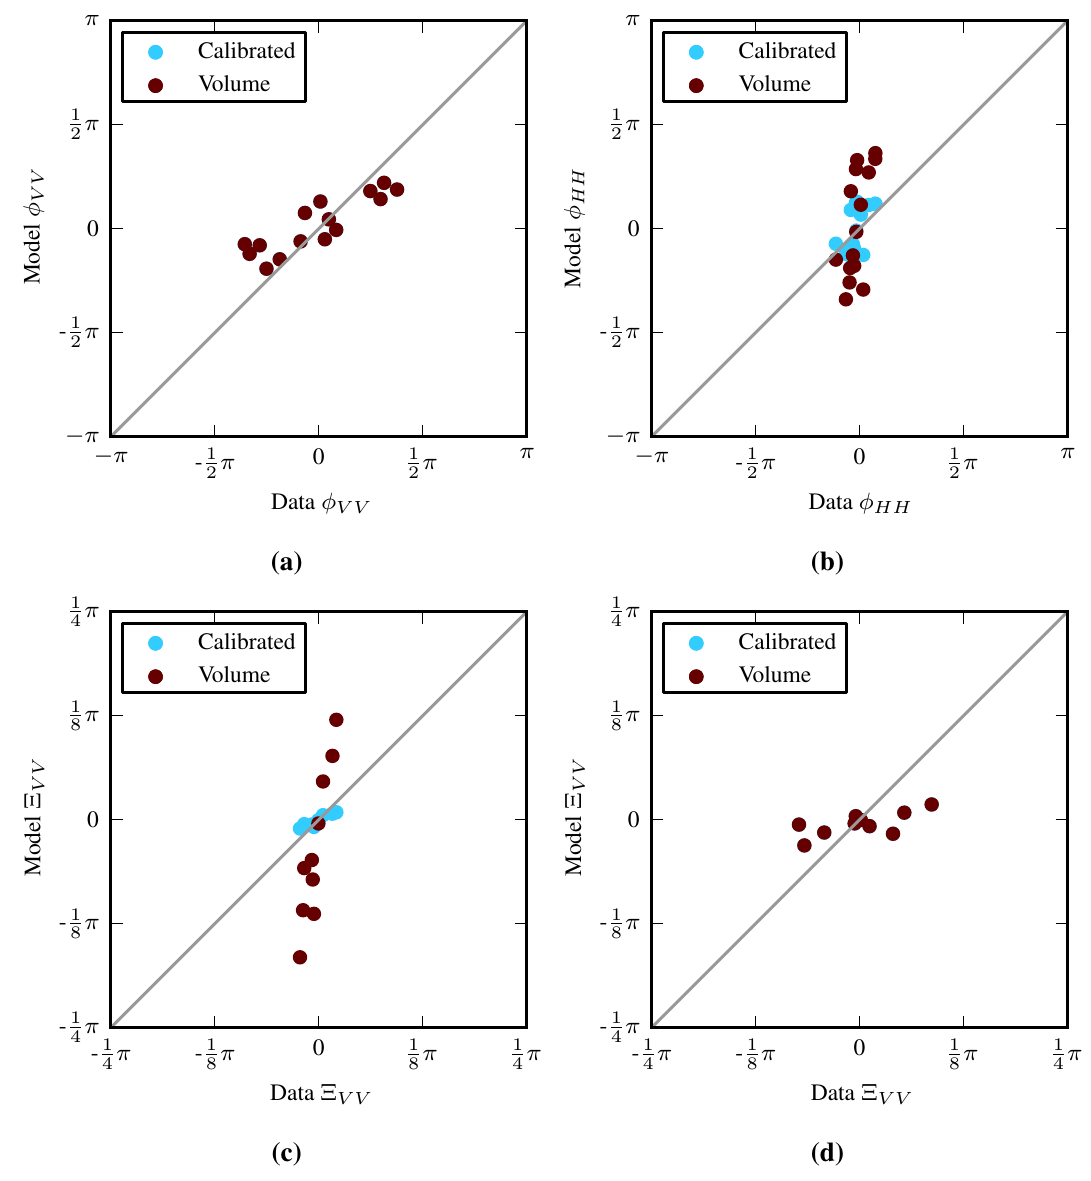
Figure 5. Comparison of predicted and measured phases or phase triplets: the volume-only predictions (in red) are contrasted with those of the calibrated model ( A “ 0 , ζ “ 0 ; in blue). The descriptions give the subROI, the observable, and the mixing model used in the predictions. ( a ) 206b, φ , Hal; ( b ) 109a, φ , Pep; ( c ) 109a, Ξ , Pep; ( d ) 326d, V V HH V V Ξ , V V